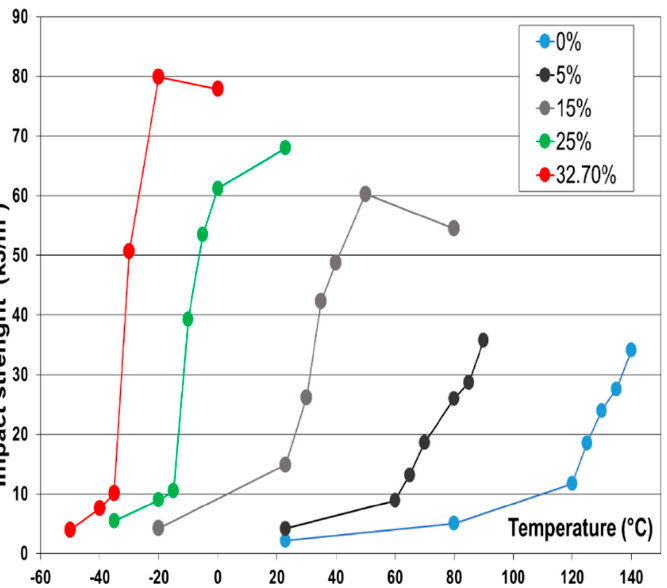
Figure 2. notched Izod impact data of polypropylenes with varying rubber contents over a broad temperature range. The rubber contents are indicated in the legend. The figure illustrates that the brittle–ductile transition shifts with increasing amount of rubber.